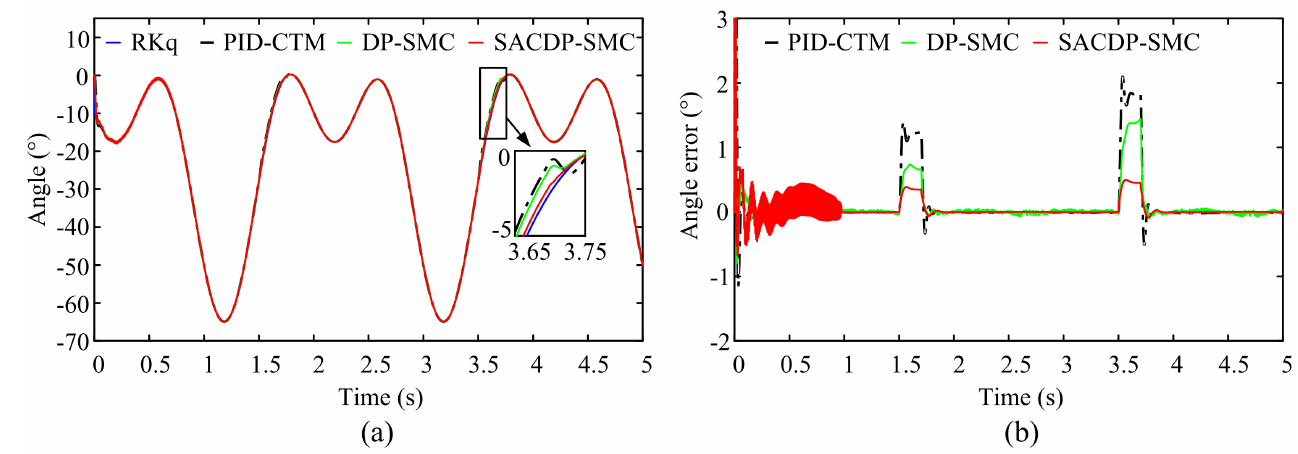
Figure 6. The tracking curve and error of the right knee. ( a ) The tracking curve of the right knee; ( b ) The tracking error of the right knee.